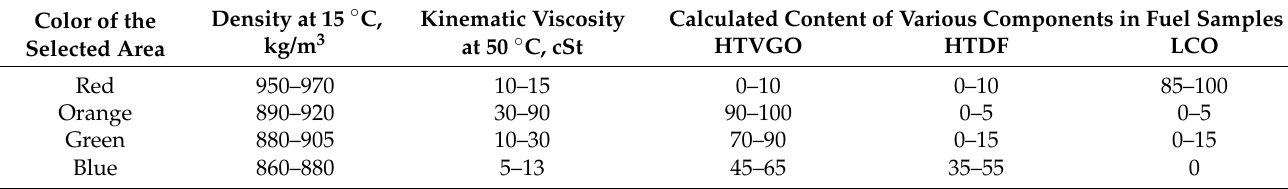
Figure 26. ULSFO batches in logarithmic coordinates [97]. Table 18. Composition of ULSFO fuel compositions